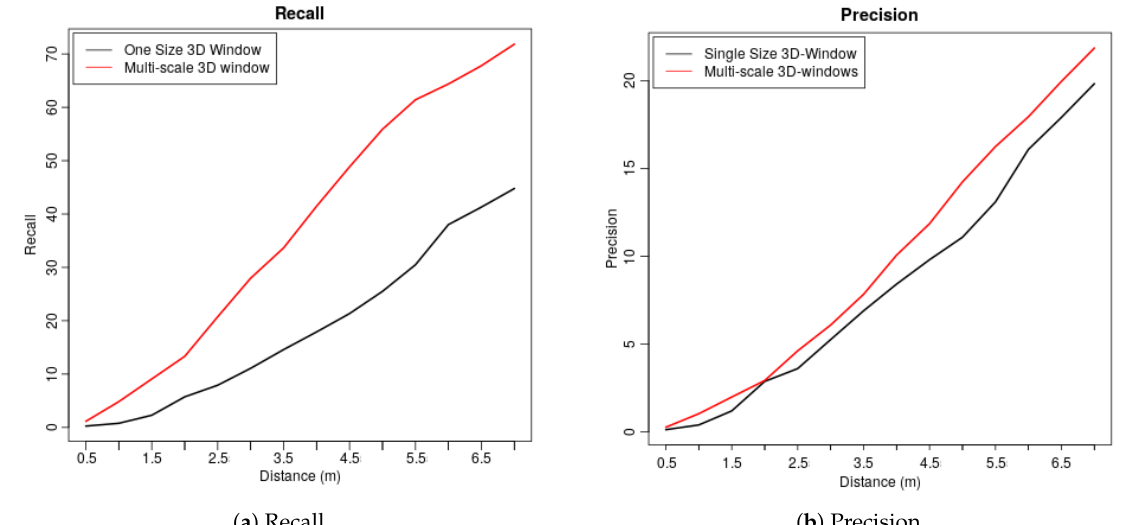
Figure 13. Average results of the two approaches: ( a ) Recall, ( b )